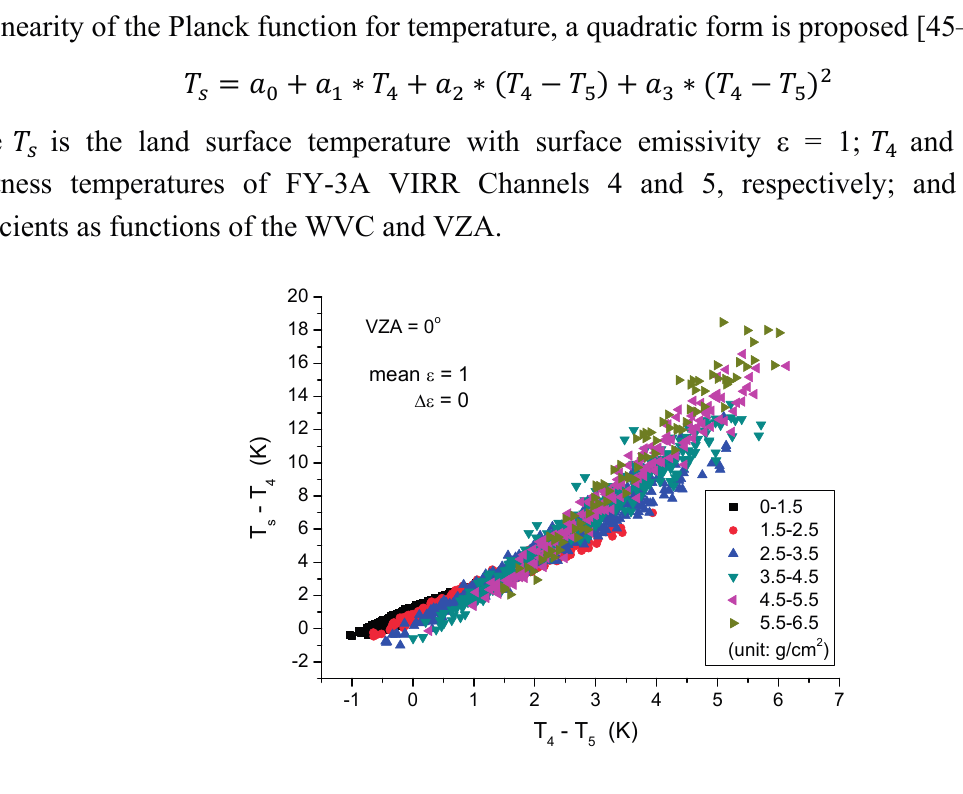
Figure 4. Relationship between (cid:1846) above-mentioned conditions with six sub-ranges of water vapor content (WVC) between 0 and 6.5 g/cm 2 ; for a mean emissivity ε = 1, the emissivity difference Δε = 0, and the viewing zenith angle (VZA) =